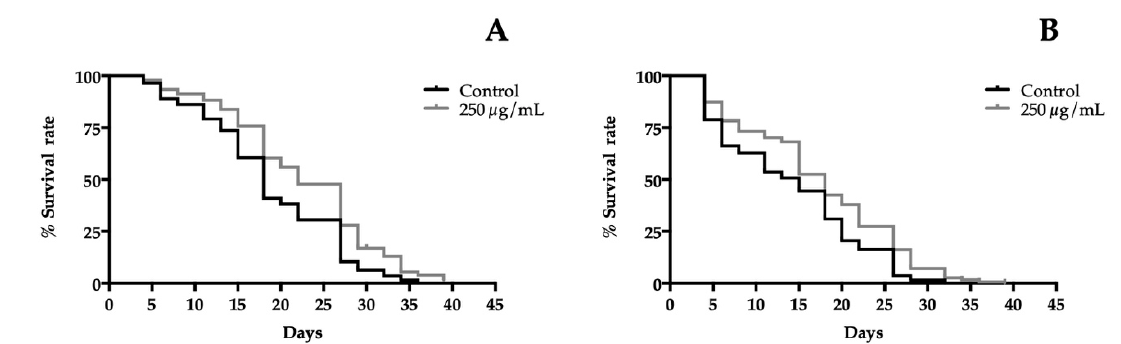
Figure 3. Effect of the highest dose tested of ( A ) orange cultivar and ( B ) yellow cultivar of T. erecta flowers extracts on lifespan of wild-type C. elegans . The mean of the lifespan for orange cultivar were: 18 days (control group), 20 days (50, 75, and 125 µ g/mL treated groups) and 22 days (250 µ g/mL treated group). For yellow cultivar were: 15 days in all groups except in nematodes treated with 250 µ g/mL, which was 18 days. The results of lifespan experiments were analyzed by using the Kaplan-Meier survival model and for significance by using a long rank pairwise comparison test between the control and treatment groups. Differences in survival curves between treatment and control groups were found in: ( A ) 50 *, 75 ***, 125**, and 250 **** µ g/mL. ( B ): 75 *, 125 *, and 250 *** µ g/mL. Differences compared to the control group were considered significant at p < 0.05 (*), p < 0.01(**), p < 0.001 (***), and p < 0.0001 (****).